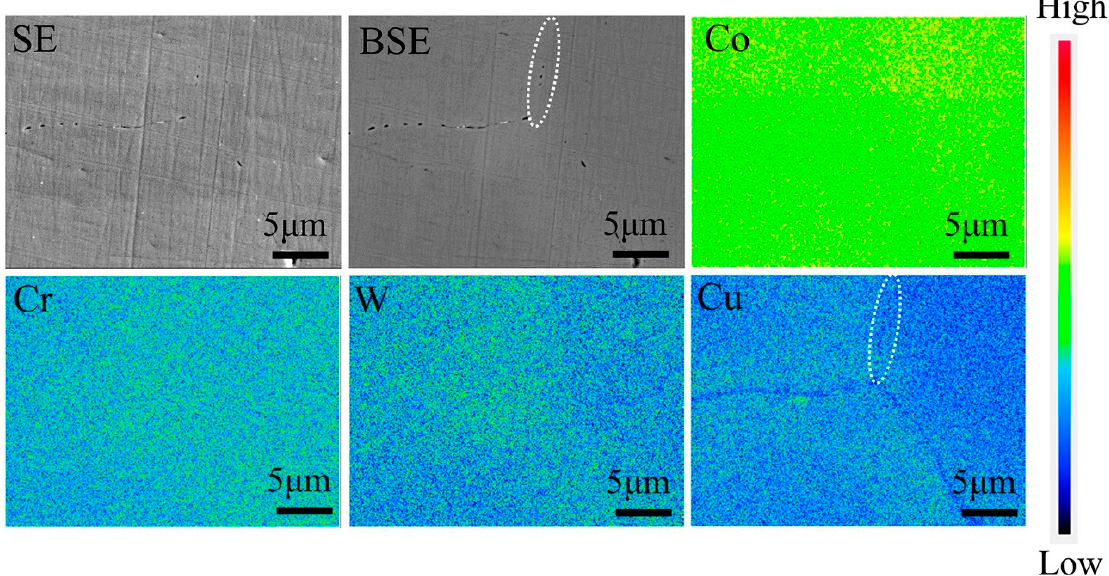
Figure 3. SEM images and corresponding EPMA elemental maps of the CoCrW-4Cu alloy at high magnification. (The white circle marked grain boundary.)